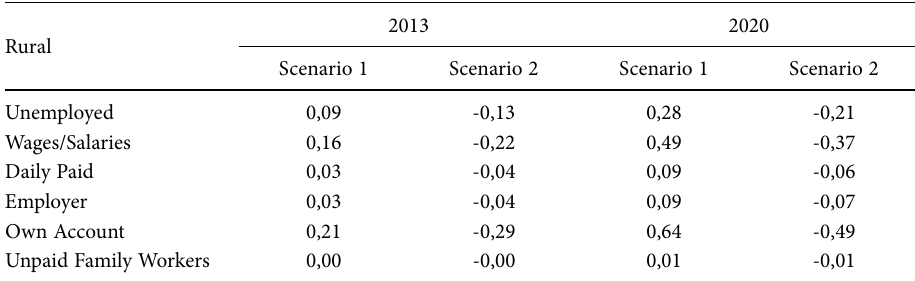
Table 7. Household income effect sourced by labour income-Open loop effect (million TL)*.